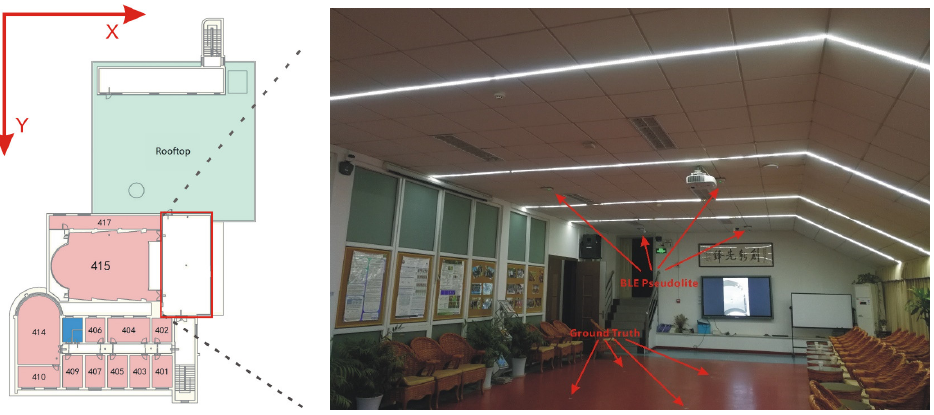
Figure 4. The experimental